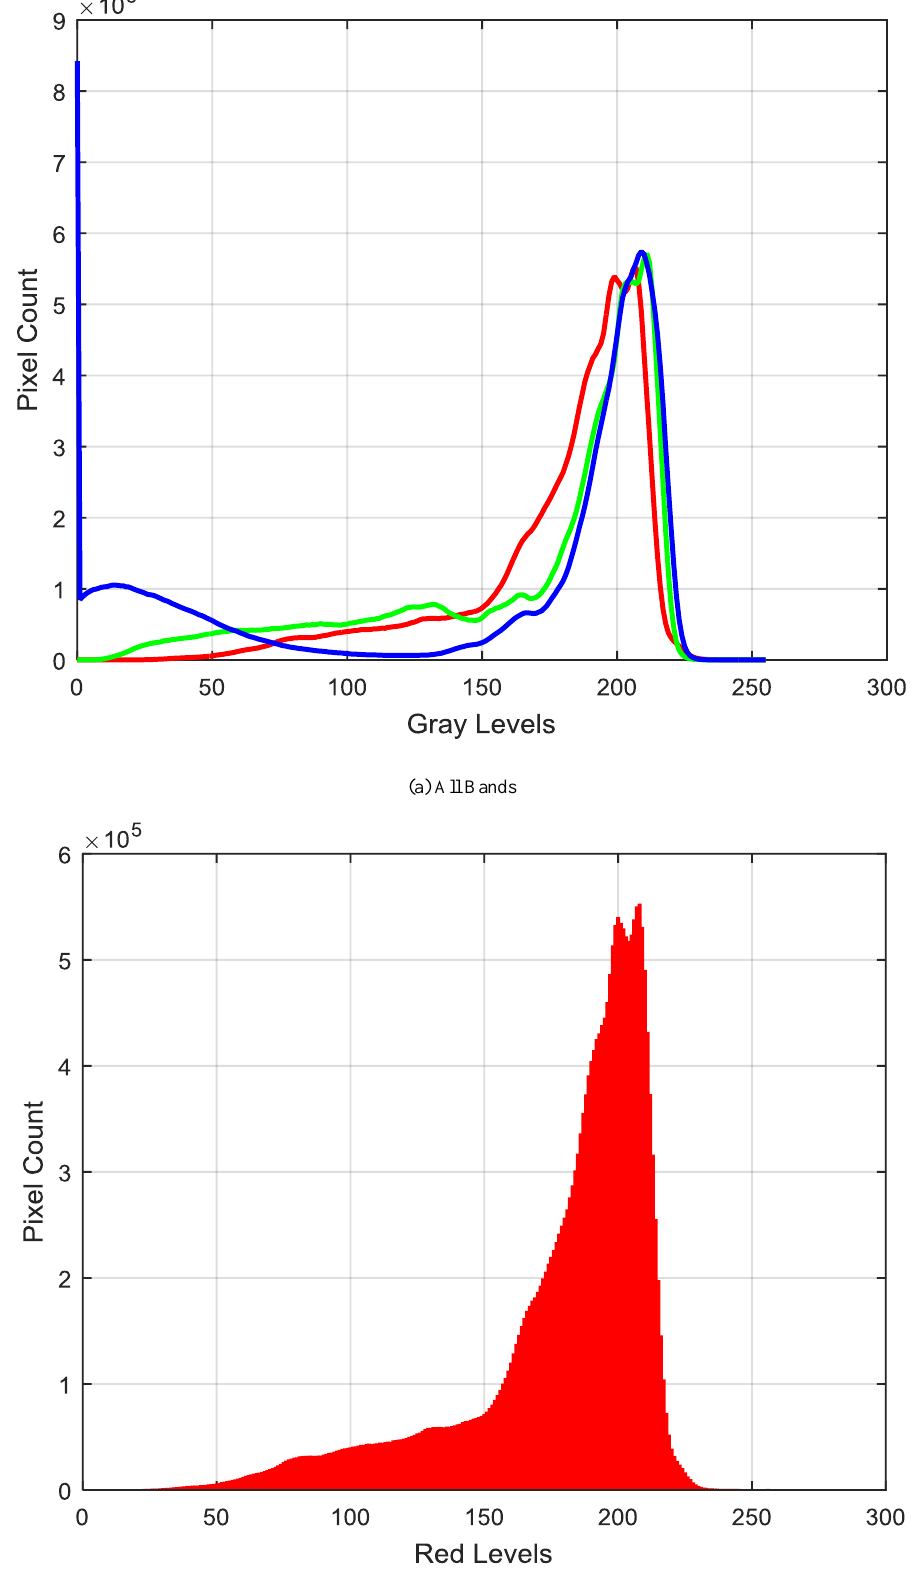
A histogram of all the RGB bands combined together in Figure 10 shows the number of pixels at the virtual and gray levels on the horizontal axis, and the RGB histograms for each color are shown on the vertical axis. The horizontal axis represents the pixel density and the vertical axis represents the average pixel size. Figure 10 shows histograms of the performance of each